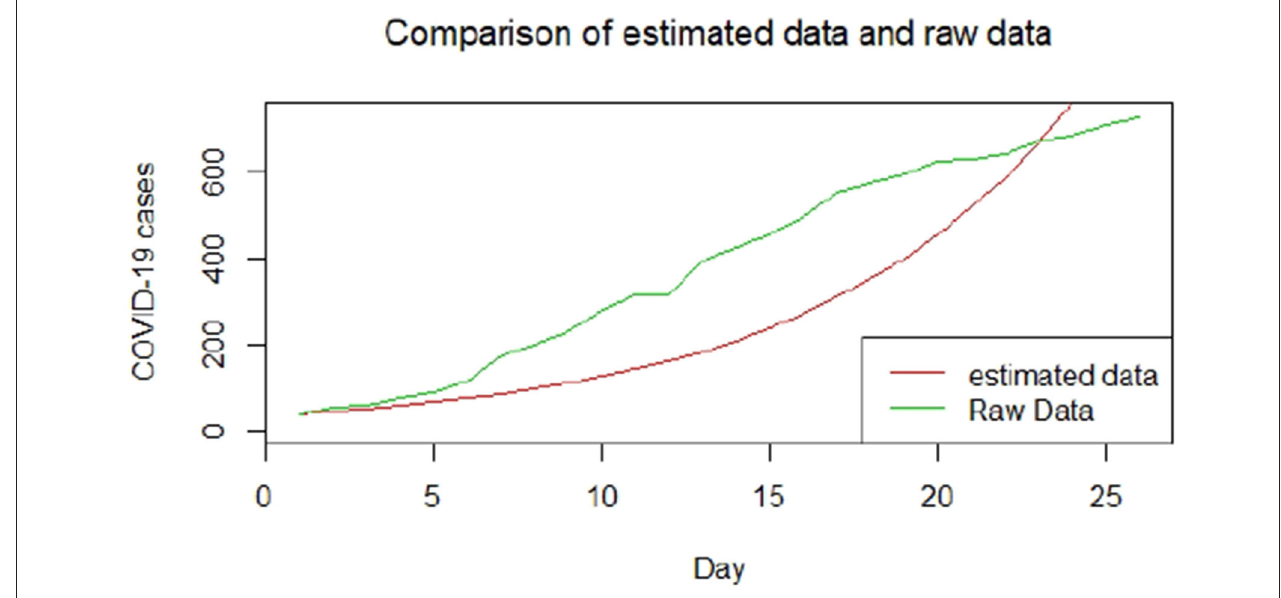
FIGURE 26 | Graph for Tunisia.